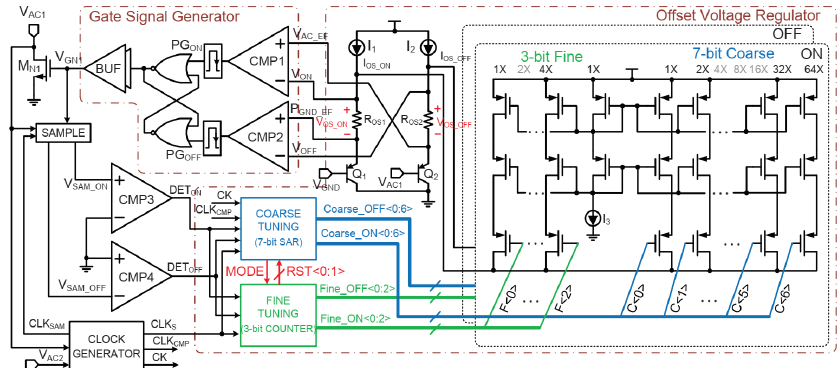
Figure 20. Architecture of digital delay compensation loop proposed in [49]. Reproduced